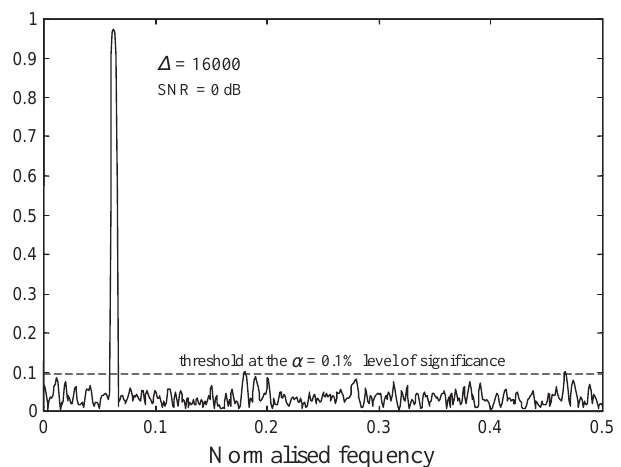
Fig.10. Estimated indicator | G ∆ ( f ) | onthe signal ofFig.1. Signal-to-noise ratio = 0 dB.For ∆ > 16000 , the tworesonance canunambiguously be recognised as not being